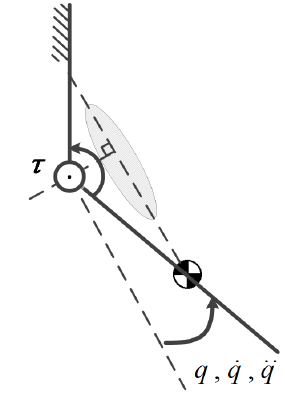
Figure 3. Rigid link